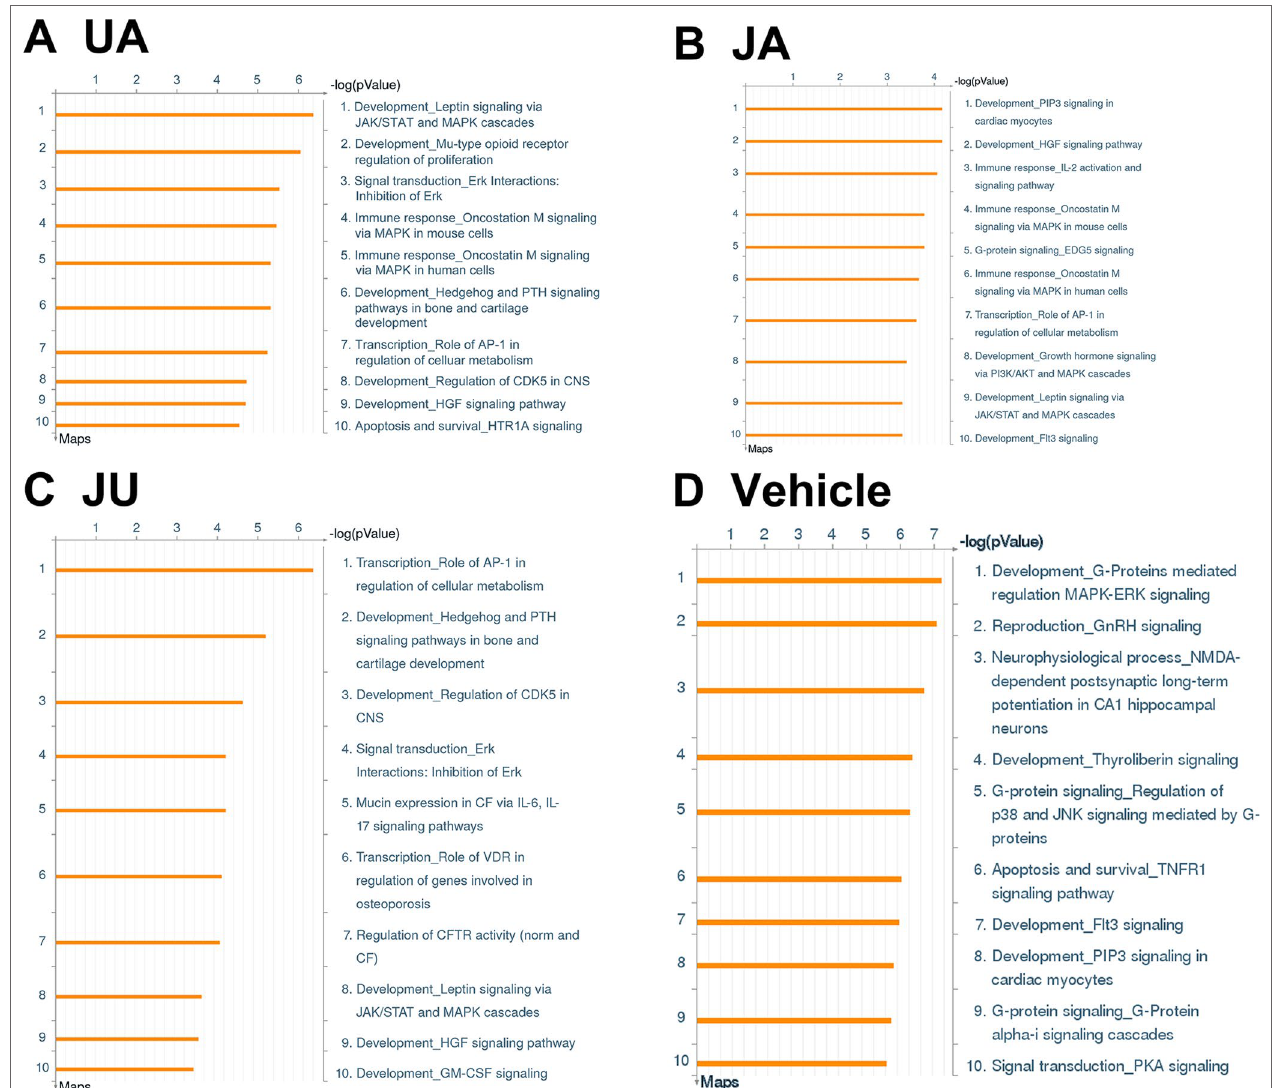
FIGURe 1 | Pathways involved differential expressed genes after ursodeoxycholic acid (UA), jasminoidin (JA), and JA and UA combination group (JU) treatments compared with model group. (A) UA group. (B) JA group. (C) JU group. (D) Vehicle group.